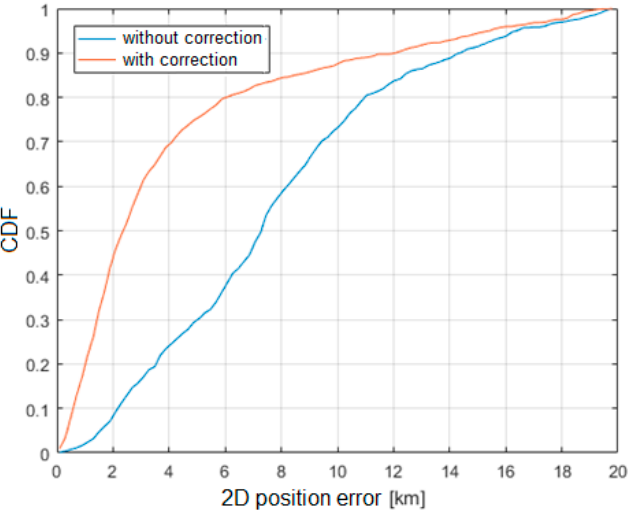
Figure 20. Cumulative distribution function of horizontal position estimation error (Foy algorithm).